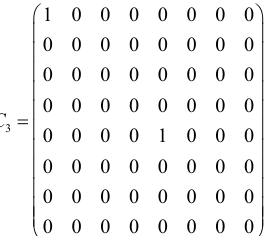
Fig. 7. Gather topology graph (dynamic).